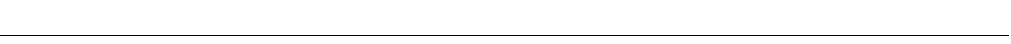
Fig. 3 Transcriptome-wide analysis of Sud C1-induced splicing regulation. a Intron retention and cassette exon skipping are the AS categories most affected by Sud C1. Number and distribution of categories of regulated AS events, with | Δ PSI | ≥ 25 ( Δ PSI: PSI of treated sample – PSI of control sample, where PSI indicates the percent spliced in) and | Δ PIR | ≥ 25 ( Δ PIR: PIR of treated sample – PIR of control sample, where PIR indicates the percent of intron retention). Non-regulated events: | Δ PSI | and | Δ PIR | ≤ 5. Splicing was quanti fi ed using VAST-TOOLS (Methods) by analyzing RNA-Seq data of total and BrU RNAs from cells treated for 3 h with 10 µ M Sud C1 vs DMSO. b Lack of correlation between gene expression and AS changes. Plots represent | Δ PSI | or | Δ PIR | (AS changes) values vs FPKM (transcription) values derived from VAST-TOOLS analysis of RNA-Seq data from total or BrU-pulsed RNAs. R indicates correlation coef fi cient. c Sequence features with signi fi cant changes between Sud C1-induced cassette exon skipping and non-differentially spliced exons. Boxplots represent the distribution of feature values (Methods) in non-differentially spliced (ndiff) ( | Δ PSI | ≤ 5) and skipped (skipp) cassette exons ( Δ PSI ≤ − 25) upon Sud C1 treatment. Outliers were discarded, boxes indicate interquartile range (IQR), whiskers extend to 1.5 times IQR. BP features and SF1 binding motif were analyzed in the 3 ′ 150 nucleotides of each intron. Black lines indicate median values. For some features (SF1 score, SVM BP score and Py-tract score), the difference between the values corresponding to the two introns fl anking the alternative exon (upstream – downstream) was calculated, thus comparing the features between the regulated 3 ′ ss and the 3 ′ ss that is used both during exon inclusion and skipping. *; **; ***: Mann – Whitney U- test (two-sided) P value < 0.01, 0.001 and 0.0001,